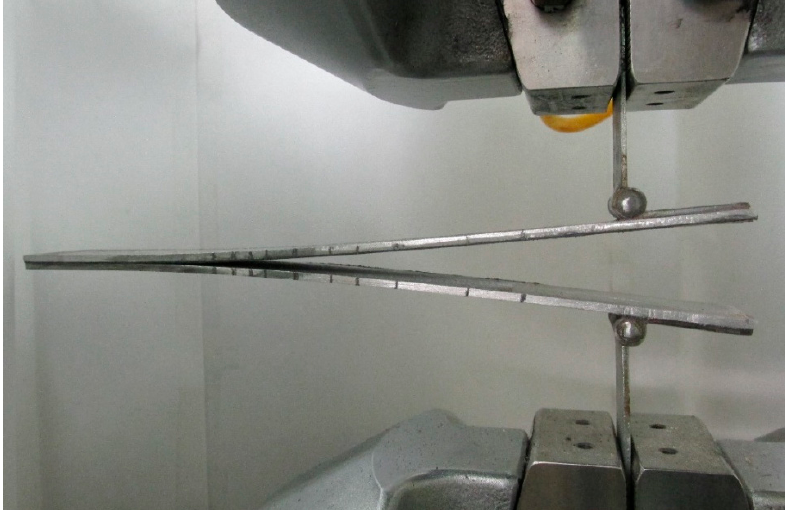
Figure 10. T-Peel test being conducted.